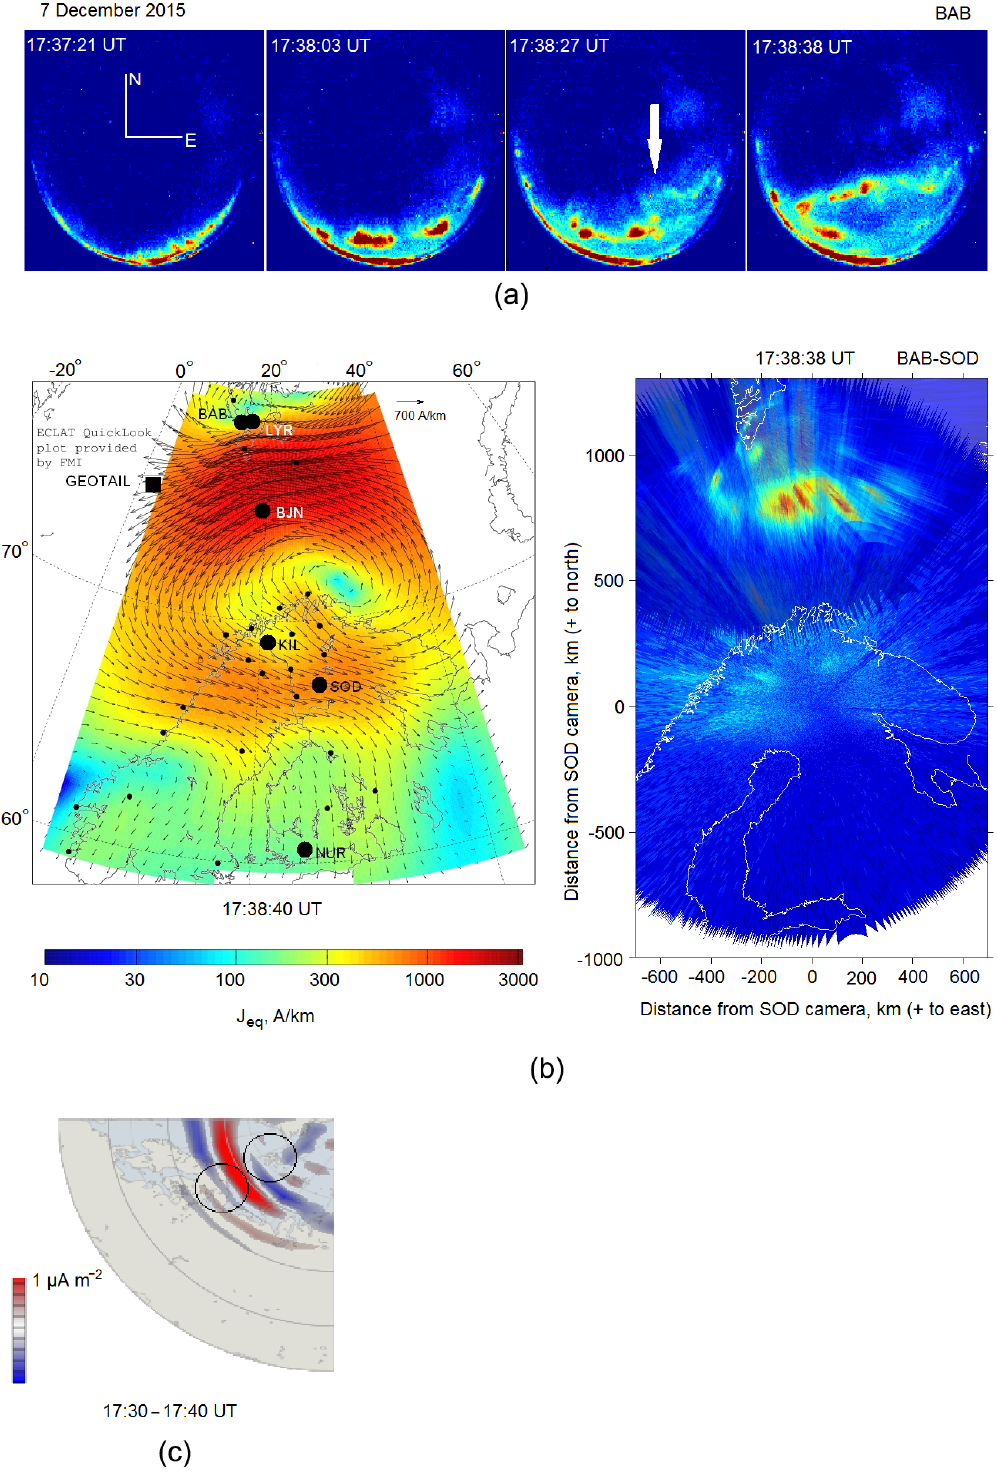
Figure 7. (a) Sequence of BAB all-sky images showing the series of bright patches along the enhancing arc and development of the torch-like structure from one of them. The left panel (b) shows a snapshot of a 2D-equivalent current. The right panel (b) shows the mapped SOD and BAB all-sky images that indicate the shape of auroras. The black square and circles indicate the position of the GEOTAIL footprint and IMAGE observatories, respectively. (c) The distribution of the FAC inferred from the AMPERE data. Upward currents are indicated in red and downward currents in blue. Circles indicate the field of view of the all-sky